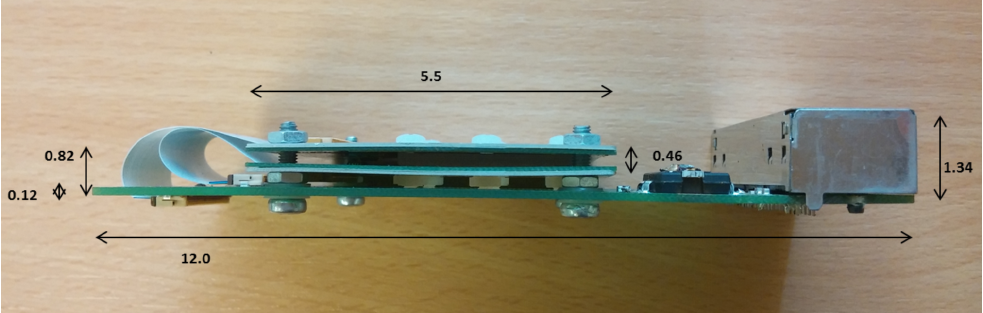
Figure 2. Timepix (TPX) hodoscope using two TPX sensors, operated at the Large Hadron Collider (LHC) Run-2. Distances are given in cm.